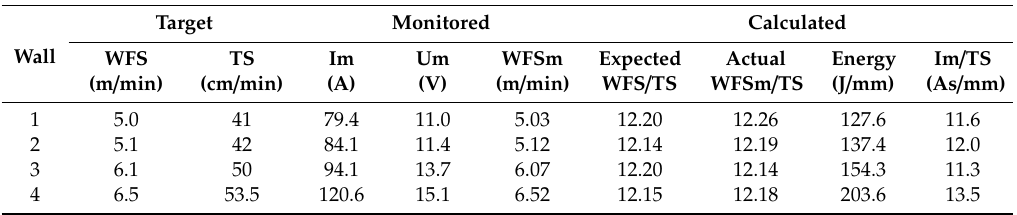
Table 3. Parameters used, monitored, and calculated during experiment to study the production increase capacity (CTWD = 15